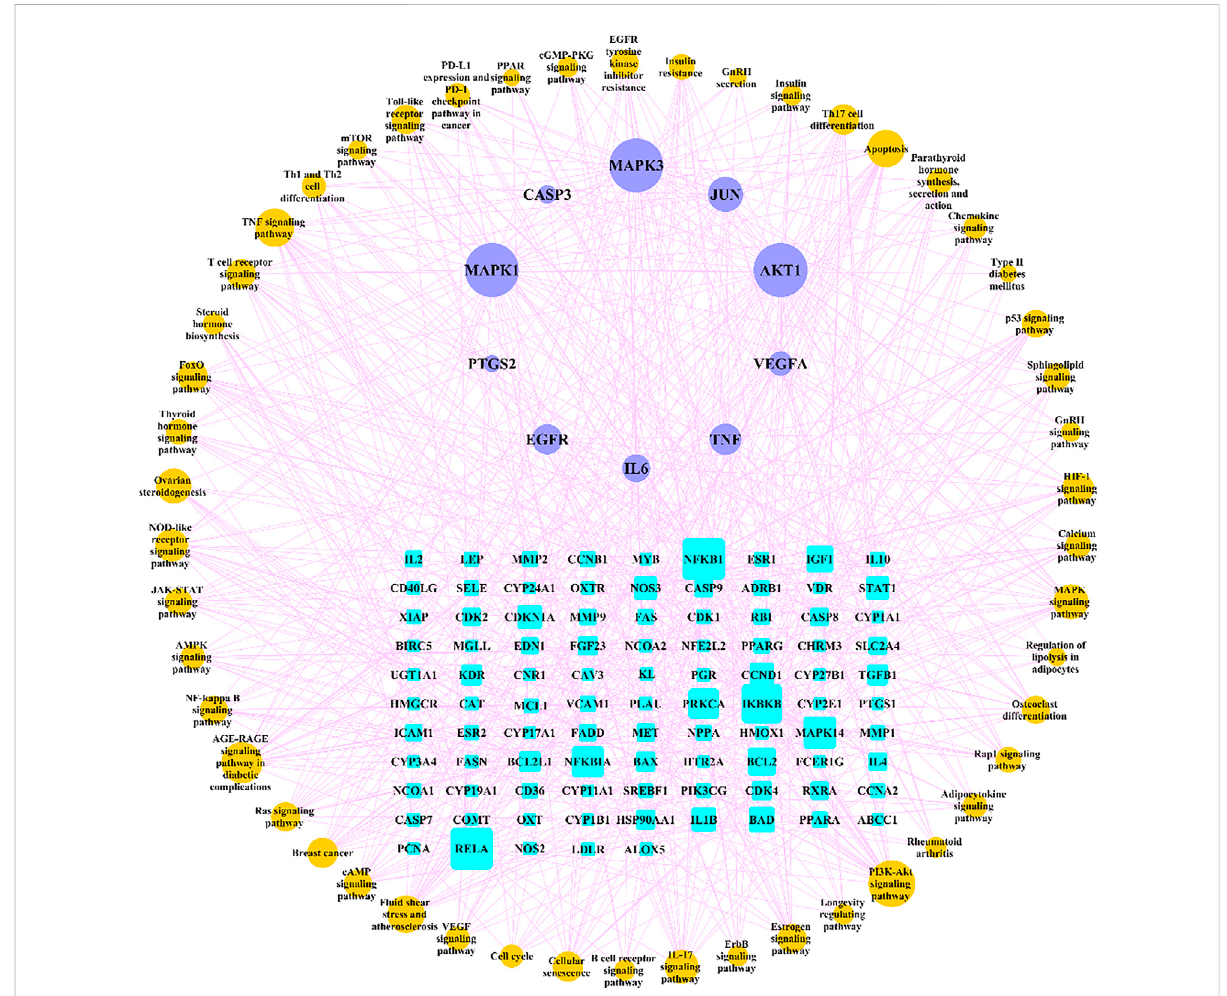
FIGURE 8 “ Target genes-pathways ” network. The cyan rectangle represents the potential target genes of Gusuibu against osteoporosis; the light blue ellipse represents the top 10 hub genes; the brown ellipse represents potential osteoporosis-related pathways.